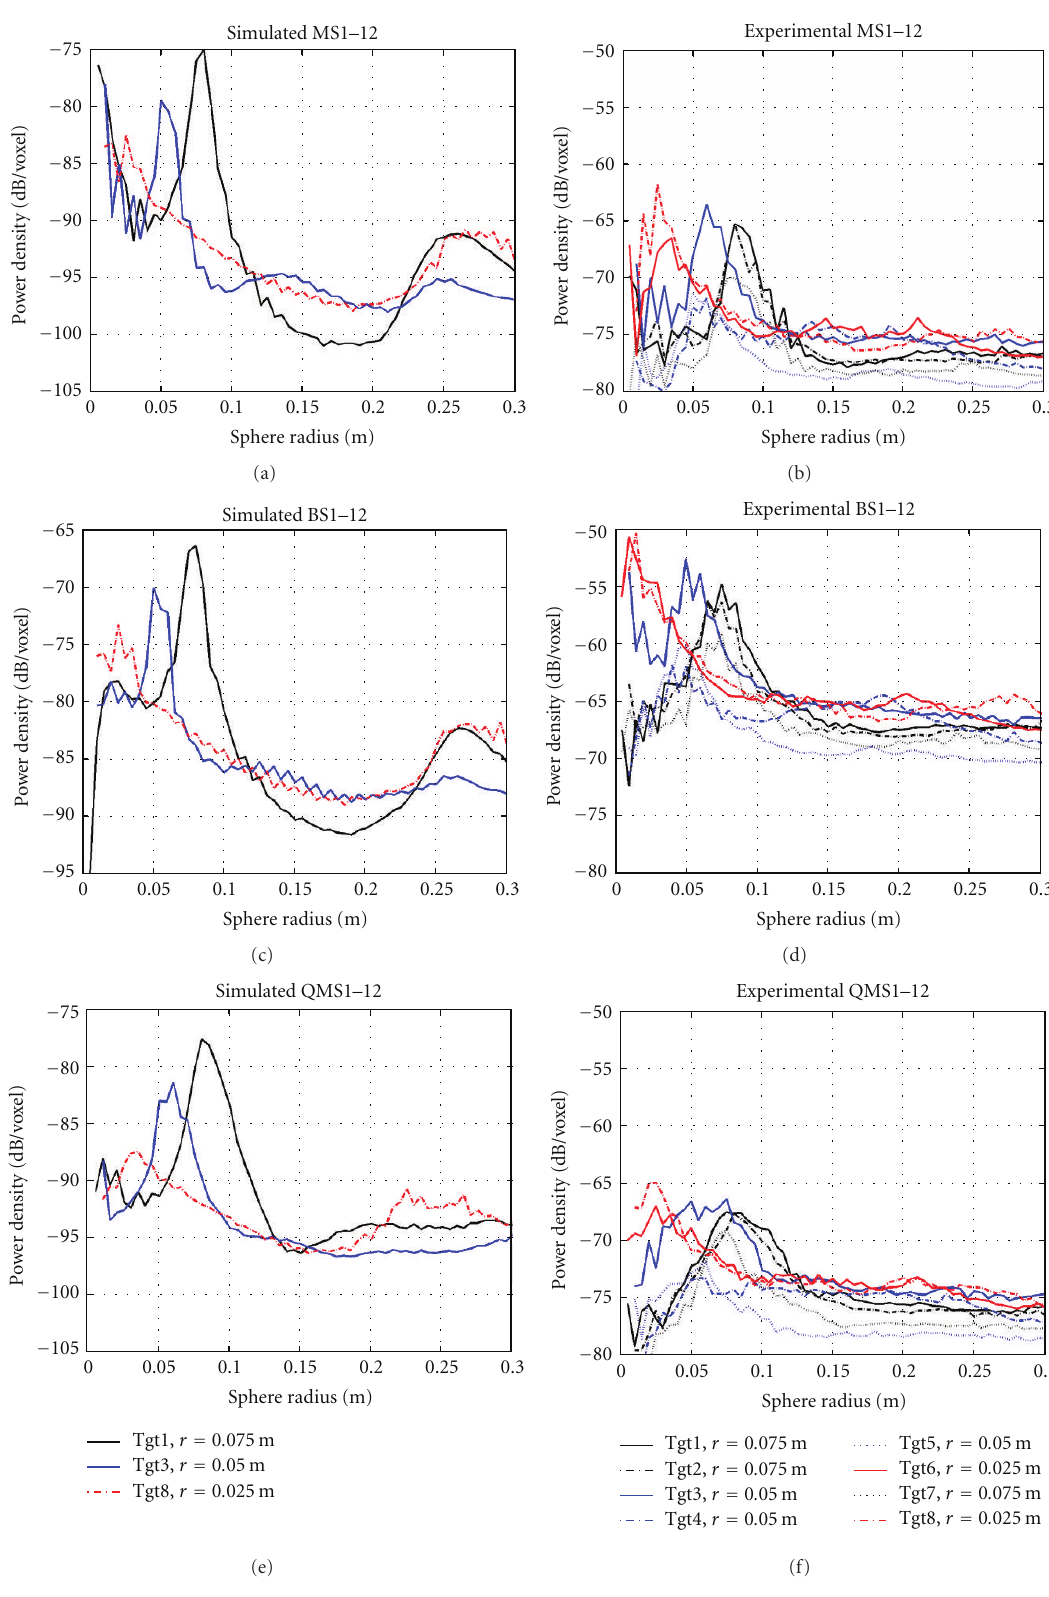
Figure 20: Spherical-surface classification performance of point-target SWISAR algorithms. Left: simulated and, Right: experimental data. (a, b) (Q)MS antennas, (Q)MS algorithm. (c, d) BS antennas, (Q)MS algorithm. (e, f) BS antennas, BS